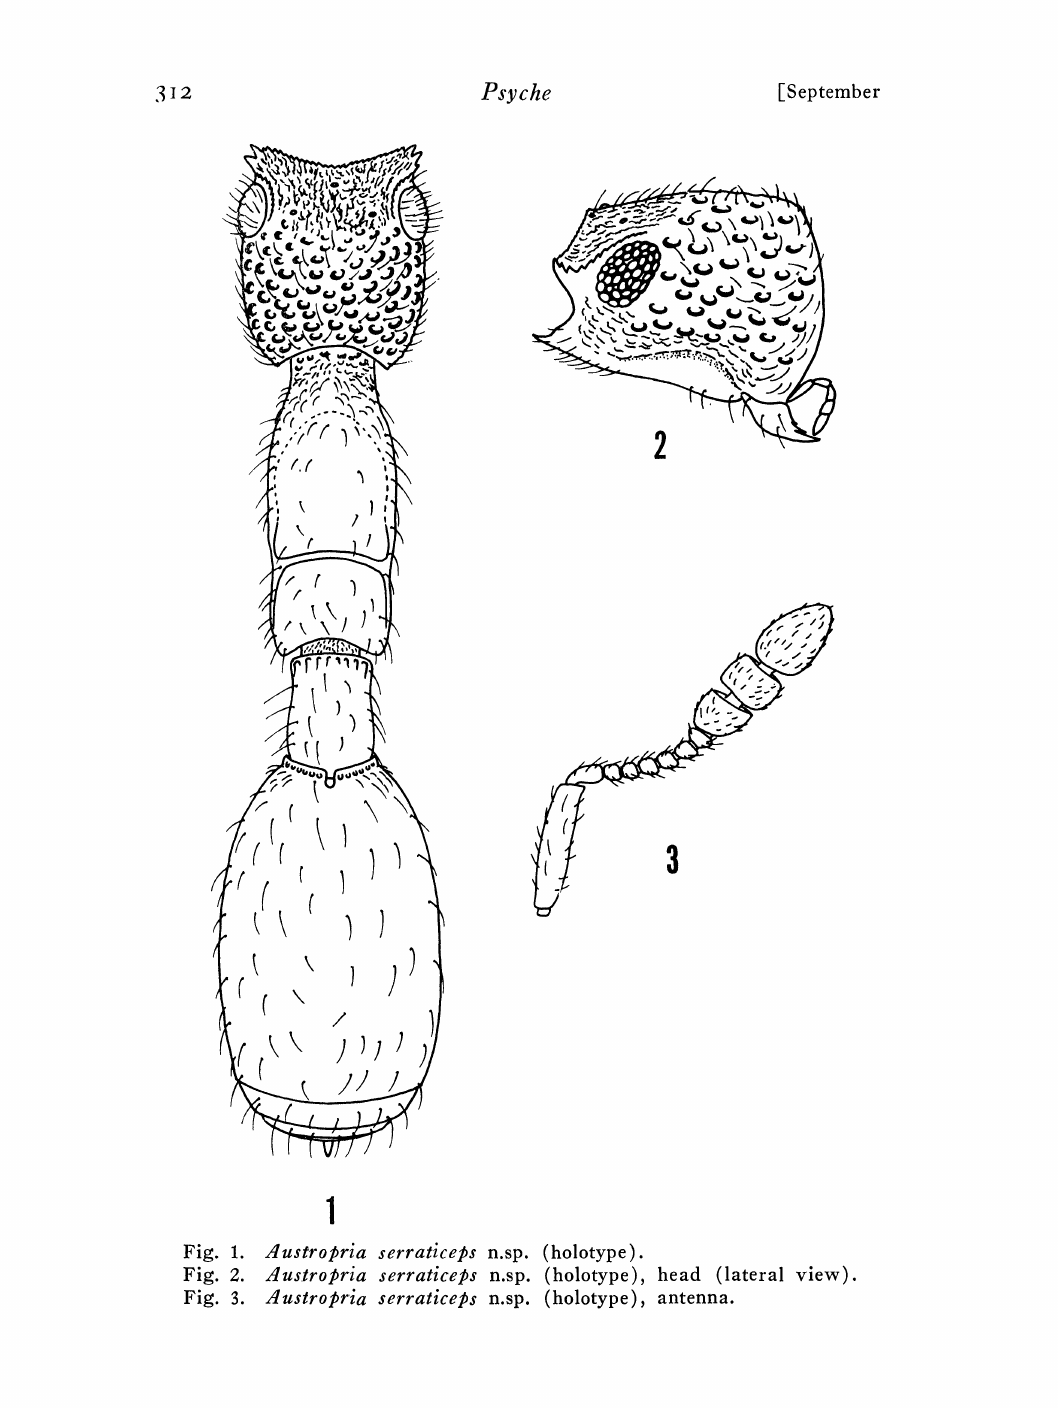
Fig. 1. dustropria serraticeps n.sp. (holotype). Fig. 2. Aus.tropria serraticeps n.sp. (holotype), head (lateral view). Fig. 3. Austropria serraticeps n.sp. (holotype),